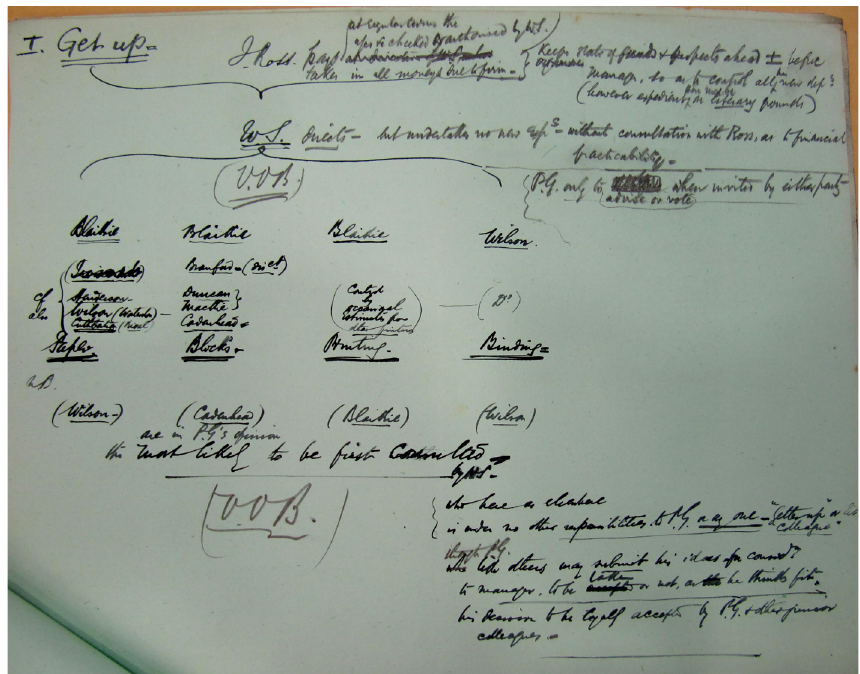
Fig. 4 ‘Get up’ plan, SUA T-GED 8/1/2, Glasgow, Strathclyde